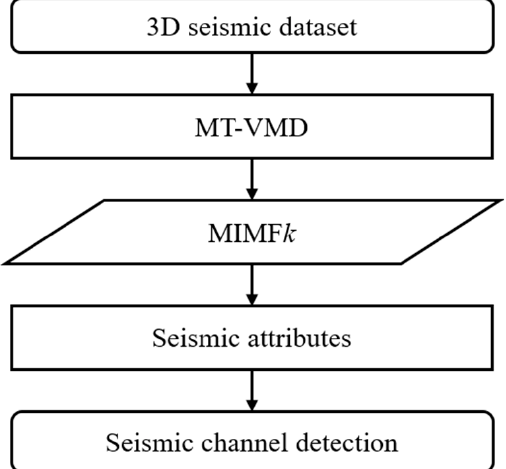
Figure 2. A flowchart of the proposed method for channel detection.